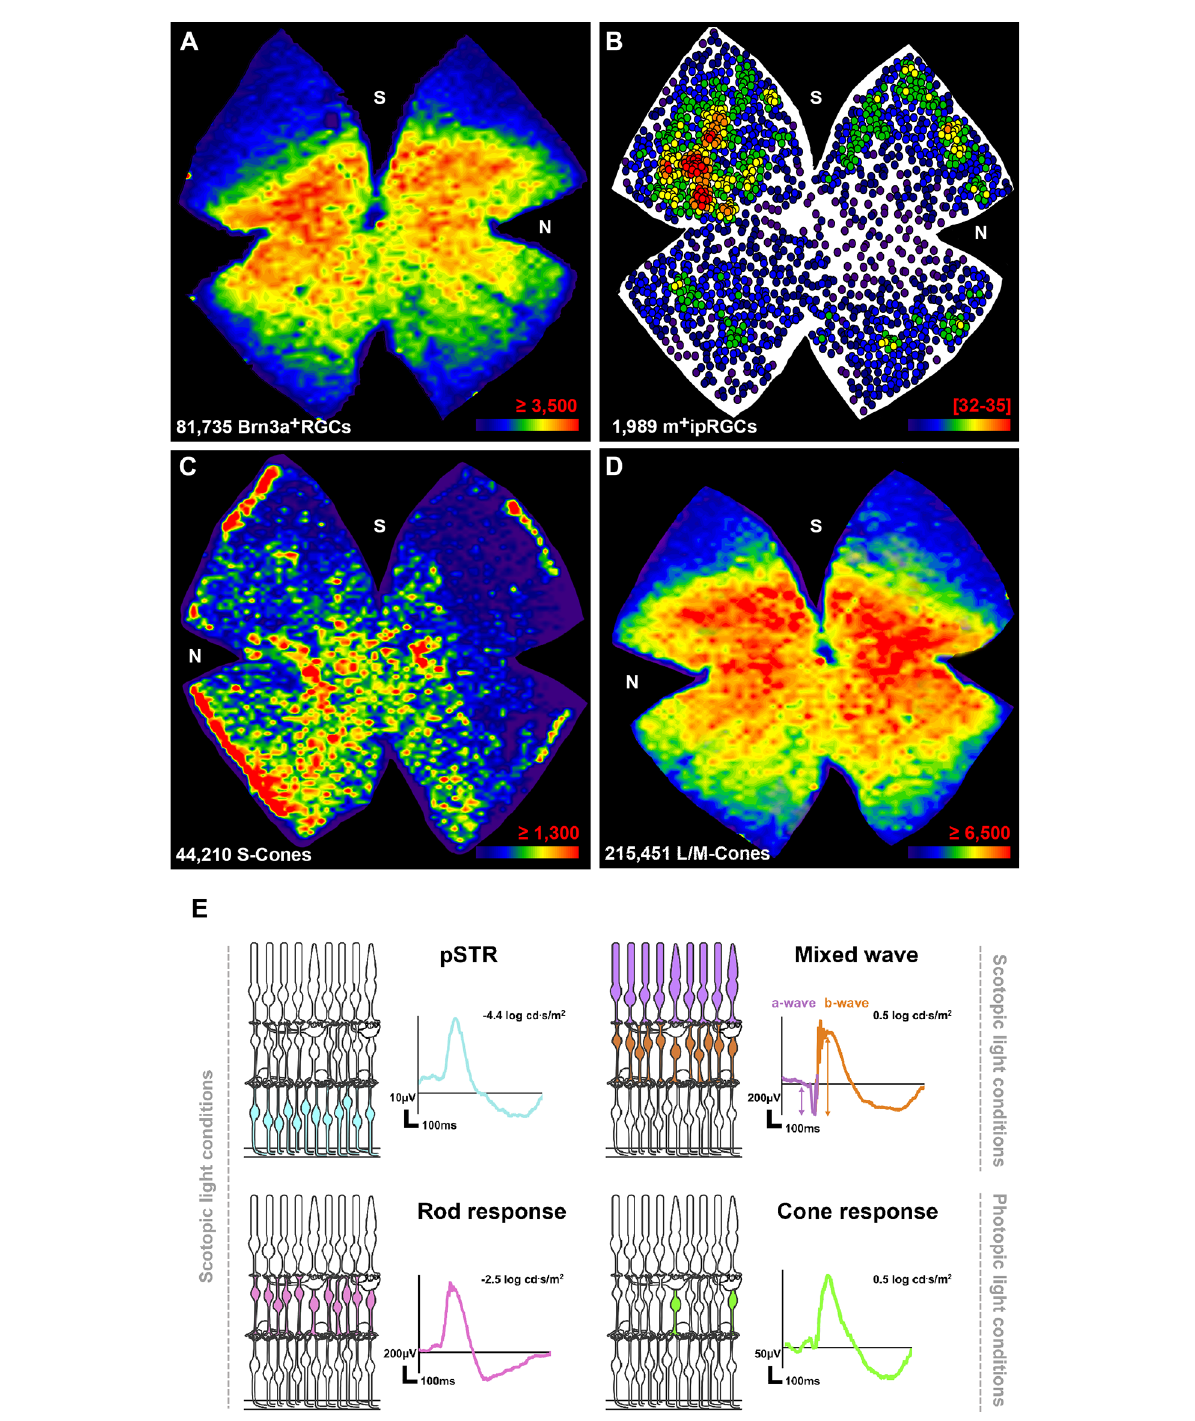
FIGURE1 Anatomy and function of the healthy albino rat retina. (A–D) Distribution of RGCs and cone photoreceptors. Maps showing the topography of Brn3a + RGCs (A) , m + ipRGCs (B) , S-cones (C) , and L/M-cones (D) in the same retina from a 2 months old female SD albino rat. After flatmounting the retina each neuronal population was immunoidentified. Next the retina was imaged first vitreal side up (RGCs), and then flipped and imaged vitreal side down (photoreceptors). Then, each neuronal population was automatically quantified (total number shown at the bottom left of each map) and the topographical maps generated. For more details see references in text and below. (A,C,D) The distribution of Brn3a + RGCs and cone photoreceptors is visualized with isodensity maps that represent cell density in the retina with a color scale that goes from